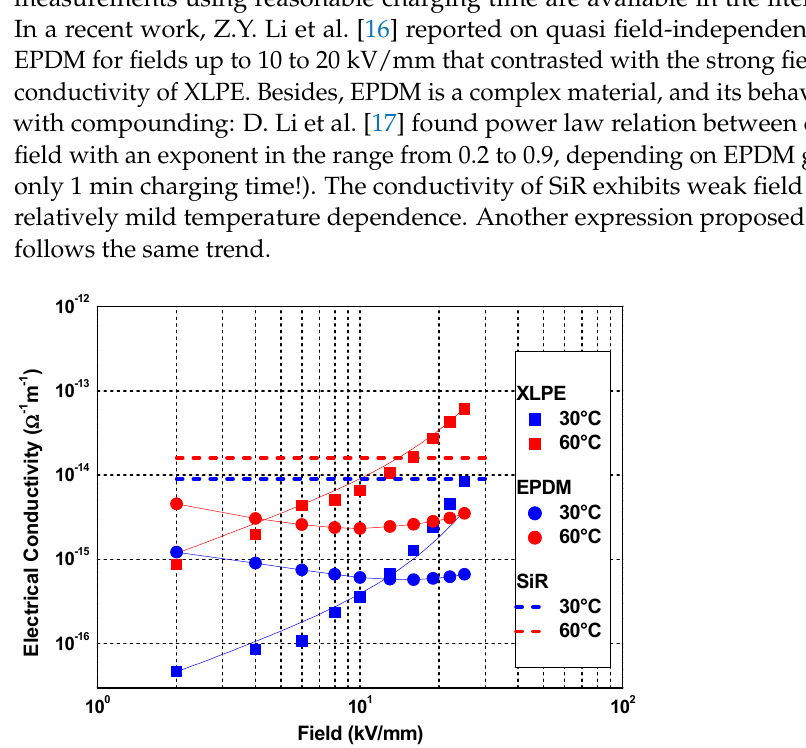
Figure 2. Field dependence of the electrical conductivity of XLPE, EPDM and silicone rubber (SiR) at 30 and 60 °C.